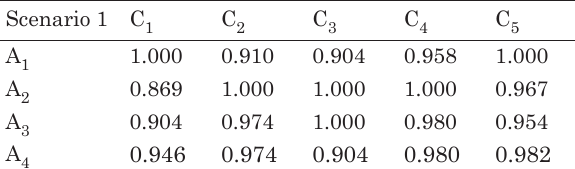
Table 6. normalized decision-making matrix for the third scenario